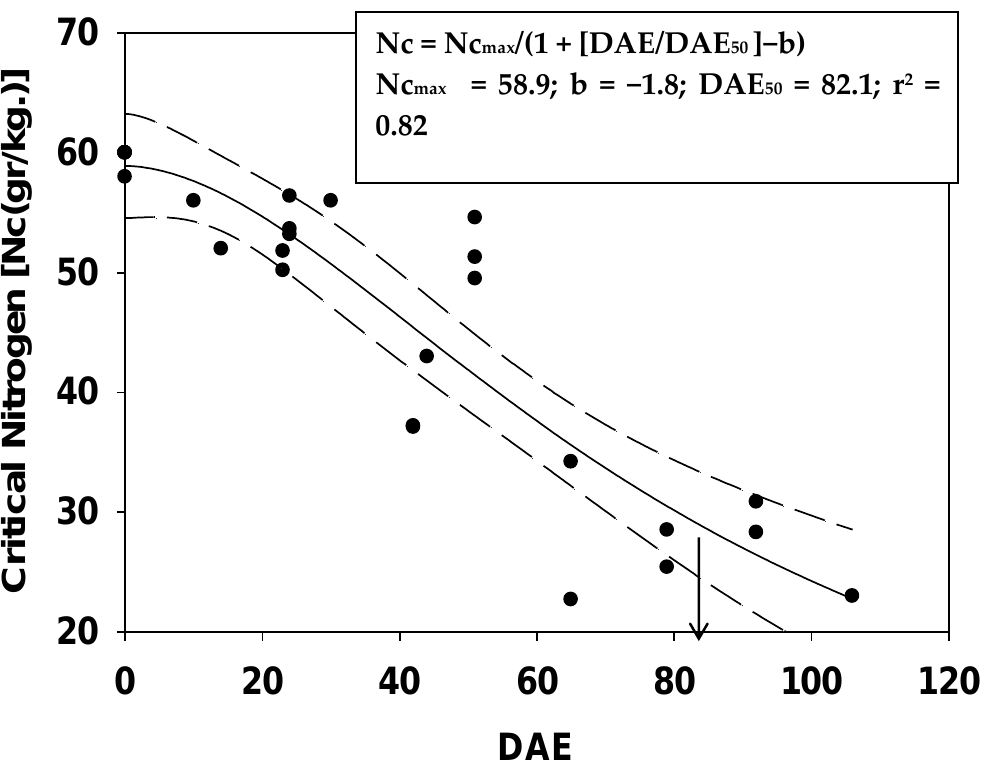
Figure 5. Dilution curve of critical nitrogen (Nc) vs. days after emergence (DAE). The points are the highest experimental values of Nc found during the sampling days. The arrow indicates the value of DAE 50 , obtained when Nc = Nc max /2, ≈ 30. The band between the dashed lines is the 95% confidence limit.